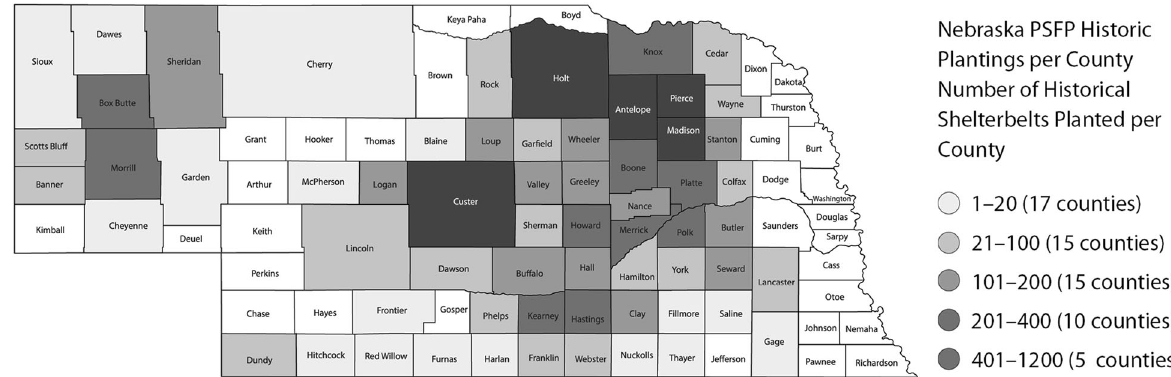
Fig. 9 Nebraska PSFP Historical Plantings per County. Map illustrating the number of historical shelterbelts planted per county (Source: the